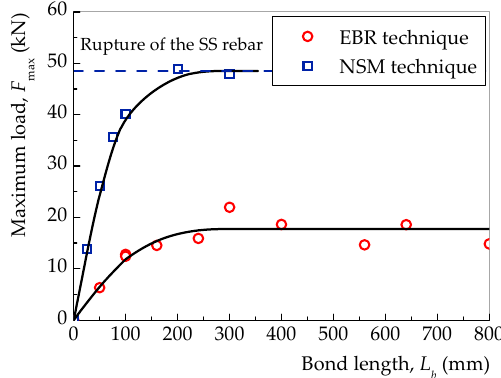
Fig. 12 Comparison between the rupture loads obtained from the EBR and NSM